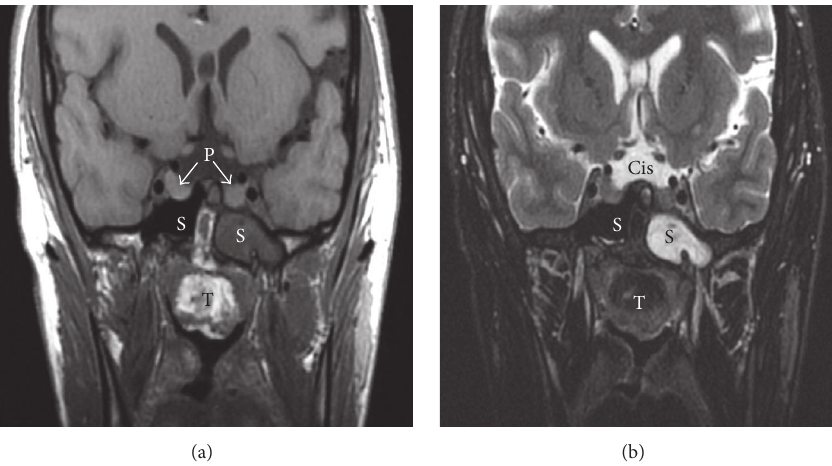
Figure3:Magneticresonanceimaging(MRI)ofpedunculatedskullbaselesion.(a)CoronalT1MRIclearlydemonstratesthetumorextending fromintracranialmidlinedefectintothenasopharynx.Thebrightintensitysignalwithinthetumor(T)andstalkbetweenthesphenoidsinuses (S) on T1 sequence represents fat, nearly pathognomonic of teratoma. Pituitary duplication (P with arrows) is best appreciated on T1 imaging as well. Of note, the left sphenoid sinus was noted to have mucosal thickening at the time of MRI compared to CT imaging (Figure 2). (b) Coronal T2 sequence at same slice location highlights the enlarged midline basilar cistern (Cis) with hyperintense signal representing cerebrospinal